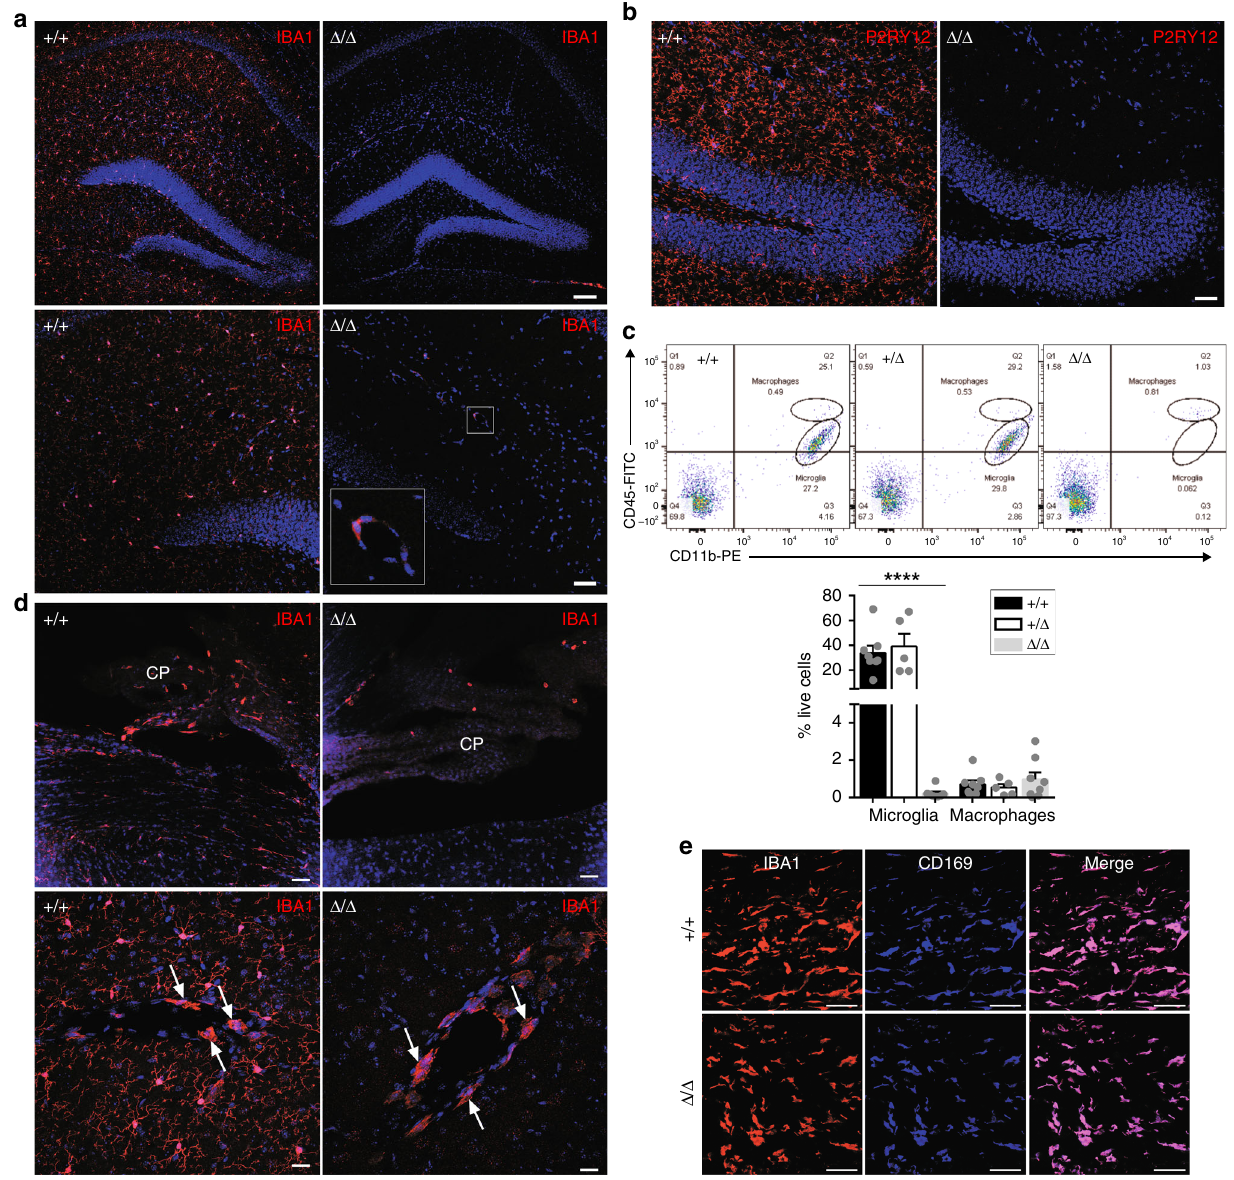
Fig. 7 FIRE deletion results in selective loss of microglia. a Cryosections of adult brains were stained with an antibody against IBA1. Boxed area shows an IBA1 + perivascular macrophage in the Csf1r Δ FIRE/ Δ FIRE mouse brain. Scale bars = 100 µ m, 50 µ m in the upper and lower panels, respectively. Images are representative of four mice per genotype. b Cryosections of adult brains were stained with an antibody against P2RY12. Scale bar = 40 µ m. c Single cell suspensions of myelin-depleted brains from males and females aged 10 weeks to 9 months were analyzed by fl ow cytometry for CD45 and CD11b expression as per 45 . Microglia = CD45 low CD11b + . Macrophages = CD45 + CD11b + . n = 8 + / + , 5 + / Δ , 8 Δ / Δ from fi ve experiments. P < 0.0001 (****) Δ / Δ compared to + / + . d Cryosections of adult brains stained with an antibody against IBA1 using the same cohort of mice in a and b . Upper panel shows the choroid plexus (CP) and white arrows point to perivascular macrophages in the lower panel. Images are representative of three mice. Scale bars = 40 and 20 µ m in the upper and lower panels, respectively. e Dissected meningeal dura mater was stained with antibodies against IBA1 and CD169. Images are representative of two mice per genotype. Scale bars = 50 µ m. All source data are provided within a Source Data excel fi le. Graphs show mean + SEM and P values were determined by two-tailed t brain and analysis by fl ow cytometry 45 con fi rms the loss of populations of CD45 hi classical macrophages associated with CD45 low /CD11b + microglia which persists up to 9 months of the vasculature, meninges, and choroid plexus with a distinct age (Fig. 7c). The full fl ow cytometry gating strategy is shown in transcriptional pro fi le 47,48 . CD45 hi cells are retained in Supplementary Fig. 8a. Heterozygous mutation (haploinsuf fi - Csf1r Δ FIRE/ Δ FIRE brain digests (Fig. 7c) This was con fi rmed by immunolocalization of CD169, shown recently to be a marker ciency) of Csf1r has been proposed as a model for the human alongside CD206 and LYVE1 for a perivascular macrophage neurodegenerative disease ALSP (adult onset leukoencephalo- population in most tissues 49 (Fig. 7d, e). The brain-to-body pathy with axonal spheroids and pigmented glia) 46 . However, there is no detectable effect of the heterozygous mutation in mice weight ratios in adult male and female Csf1r Δ FIRE/ Δ FIRE mice remains unchanged (Supplementary Fig. 8b). ( Csf1r Δ FIRE/ + ) on microglial numbers. The brain also contains